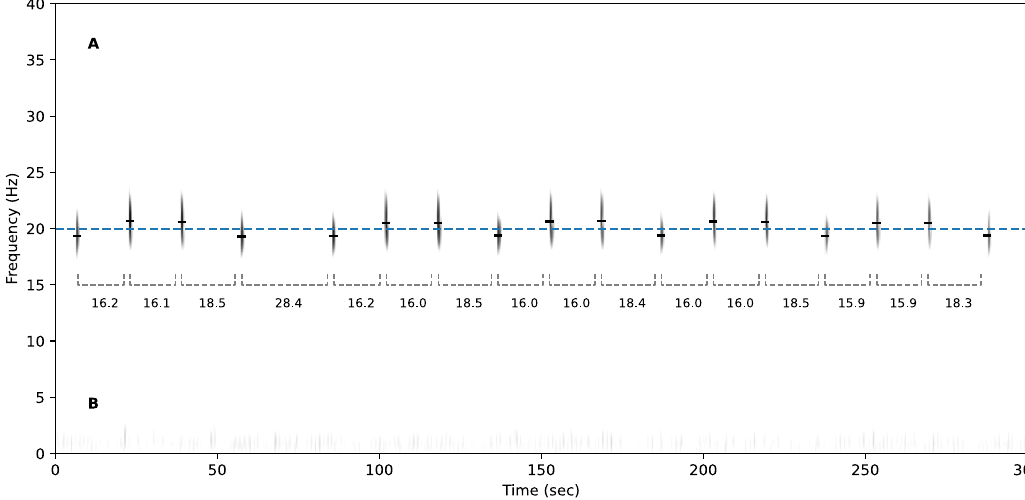
Figure 1. Spectrogram of a fin whale pulse sequence recorded by the Bombyx buoy in October 2018. Spectrogram parameters are described in section "Spectro-temporal pulse analysis". Dashes show the center frequencies of the detected pulses, with grey dashed lines showing the IPIs. The blue dashed line denotes the discrimination threshold between A and B pulse types, at 20